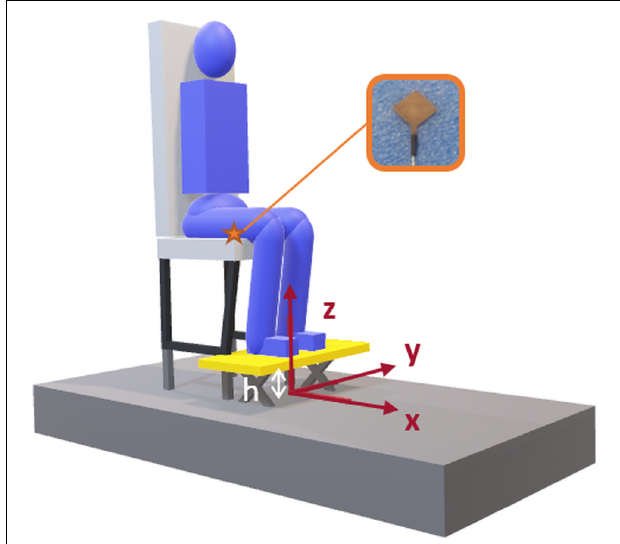
FIGURE 1 | Seat on the force platform. Axes were as follows: x -axis is along the anteroposterior direction and points forward, y -axis along the mediolateral axis, pointing to the left, and z -axis follows the vertical direction, pointing